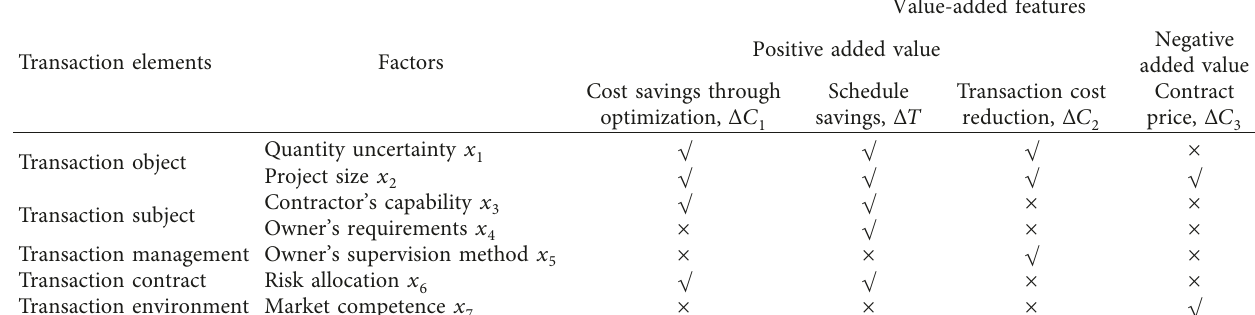
Table 4: Value-added way analysis matrix.